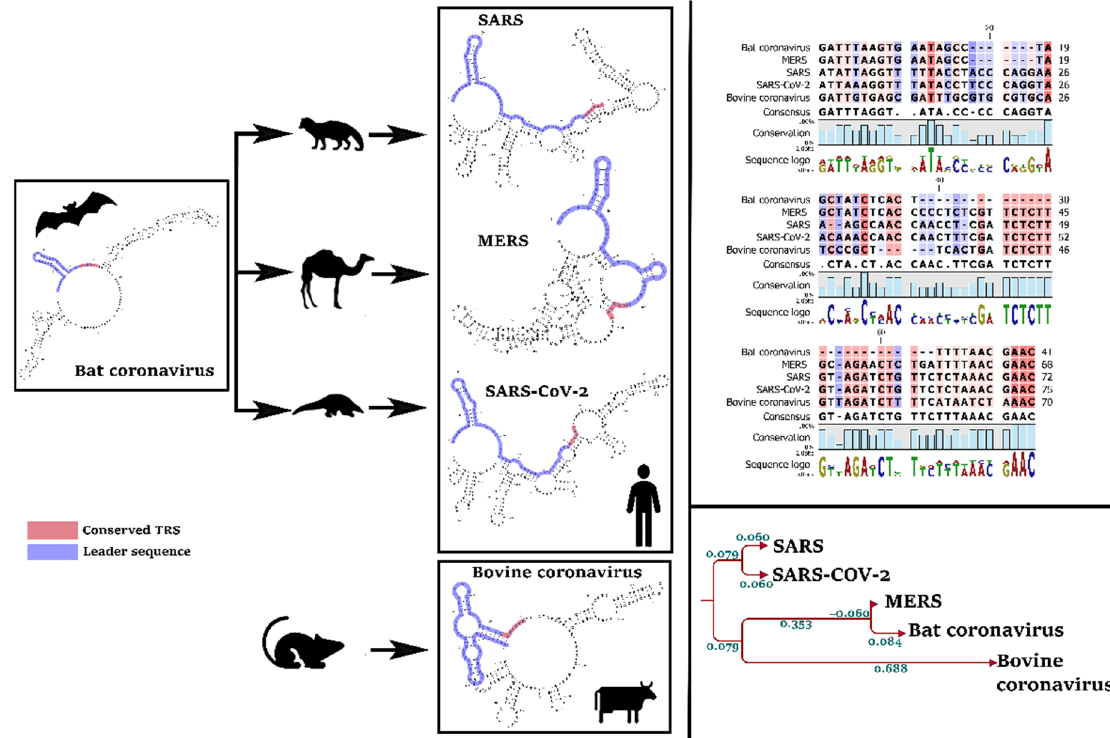
Figure 3. Evolution of “leader sequence” and TRS (transcription regulatory sequence) in the 5’UTR of human pathogens (SARS, MERS, and SARS-CoV-2) and non-human pathogens (bovine). We found a significant evolution pattern in SARS- CoV-2 compared with the other coronaviruses.